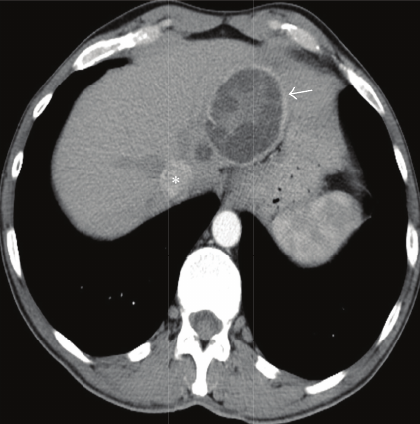
Figure 1: Contrast-enhanced CT scan reveals typically hydatid liver cyst as CE 3a cyst following the WHO classification (arrow) adjacent to the IVC (asterisk).